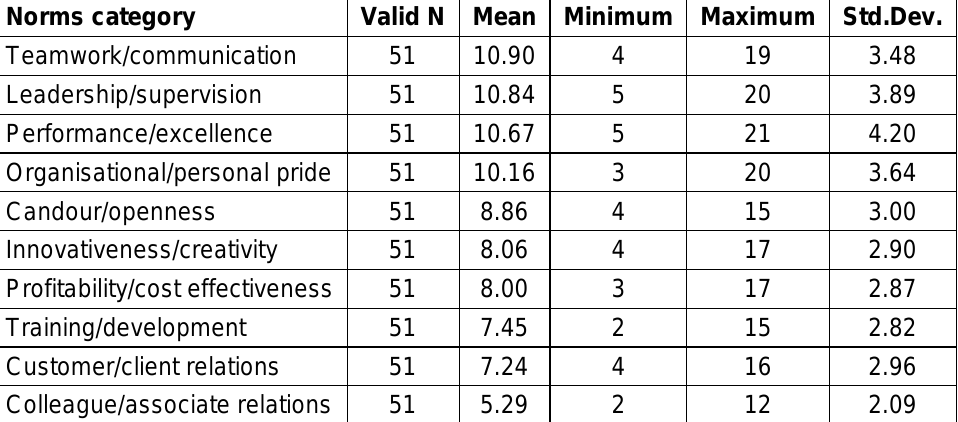
Results of mean scores indicating respondents’ perception of norms of